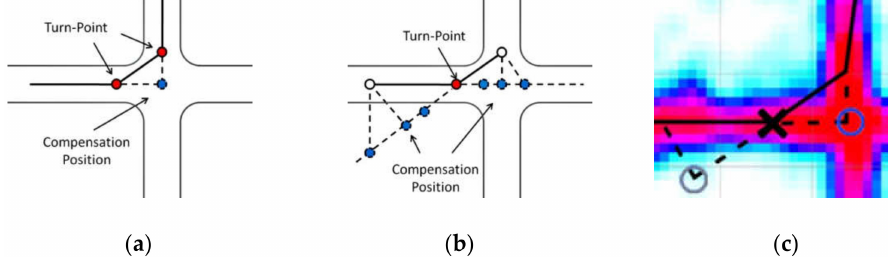
Figure 4. Turn-point compensation process: ( a ) compensation position by Wu’s method; ( b ) series of candidate positions by our method; ( c ) density map helps to determine the optimal